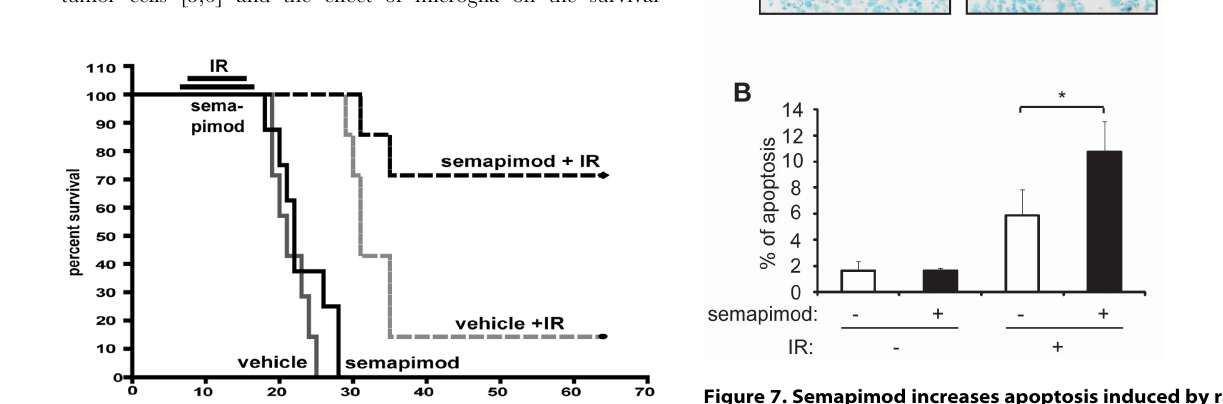
Figure 7. Semapimod increases apoptosis induced by radiation invivo . GL261 tumors were generated in mice and treatments were carried out as described in Fig. 6, except that the total radiation was 8 Gy. The mice were euthanized the day after the last radiation treatment. Frozen brain sections were analyzed for apoptosis using TUNEL staining as described in Materials and Methods. (A) Micrographs of tumor sections illustrating TUNEL staining. (B) Quantification of TUNEL staining. The percentage of apoptotic cells was calculated using 20–60 micrographs per tumor section. Data shown represent the average + / 2 SEM of 3–4 different tumors. *: p , 0.05 student’s 2 tailed t- test.